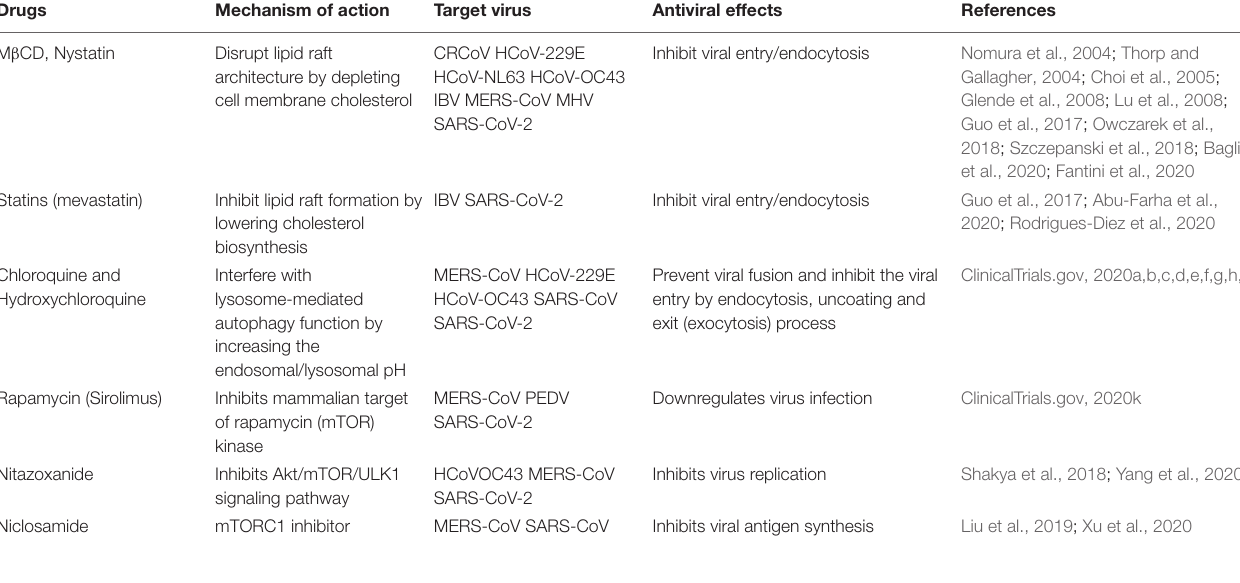
TABLE 1 | Function of lipid rafts and autophagy in coronavirus lifecycles: overview on